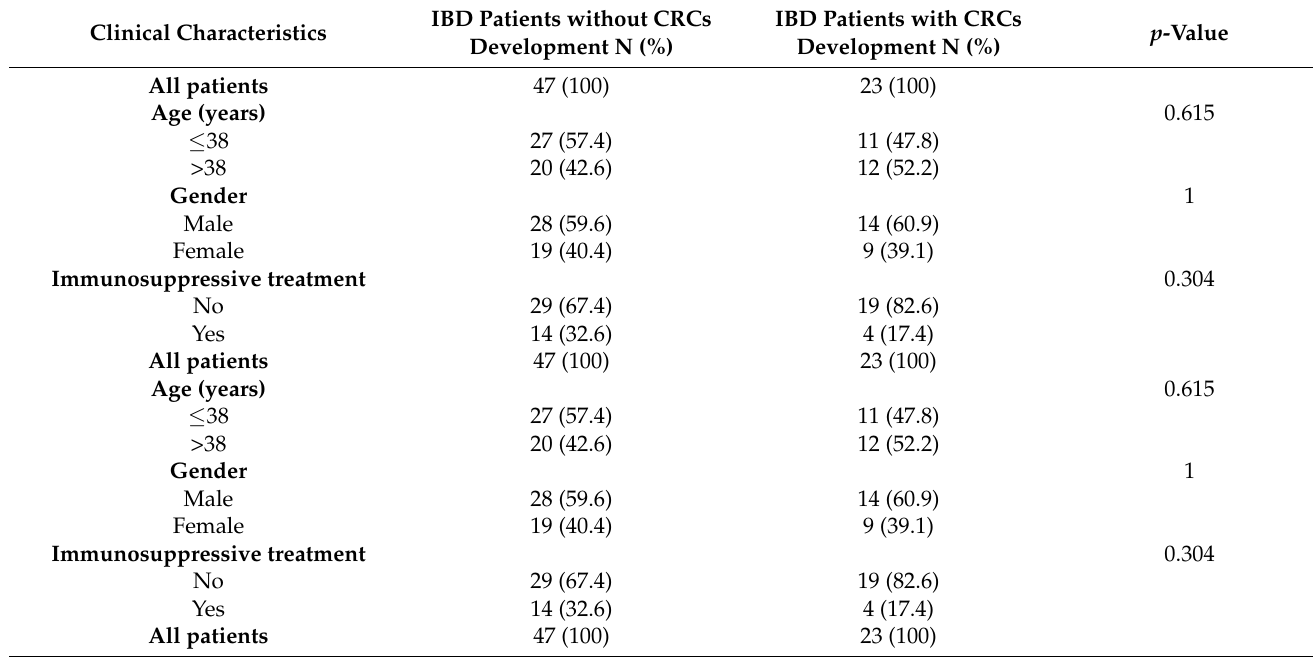
Table 2. Clinical characteristics of IBD patients at the time of the study inclusion.